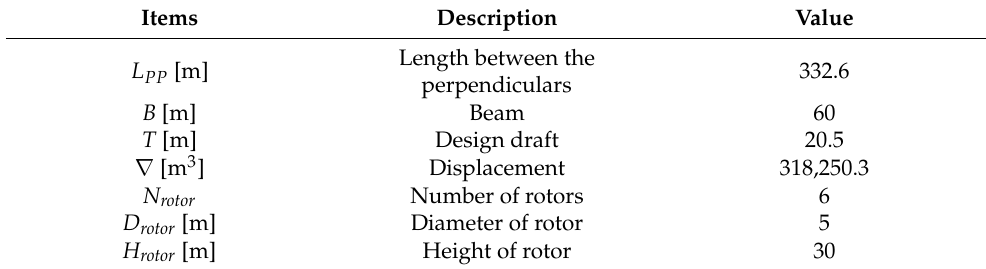
Figure 3. Propeller’s open water performance ( left ) and rotor’s air dynamic performance ( right ). Table 1. Principal dimensions of the VLCC.